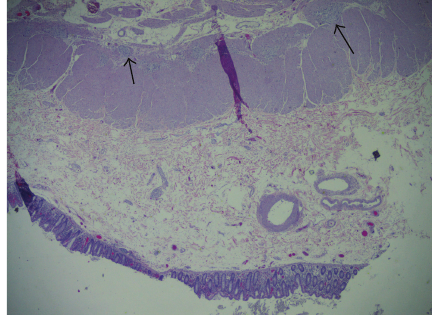
Figure 1: Low-power cross section showing lymphocytic infiltrate into the myenteric plexus.